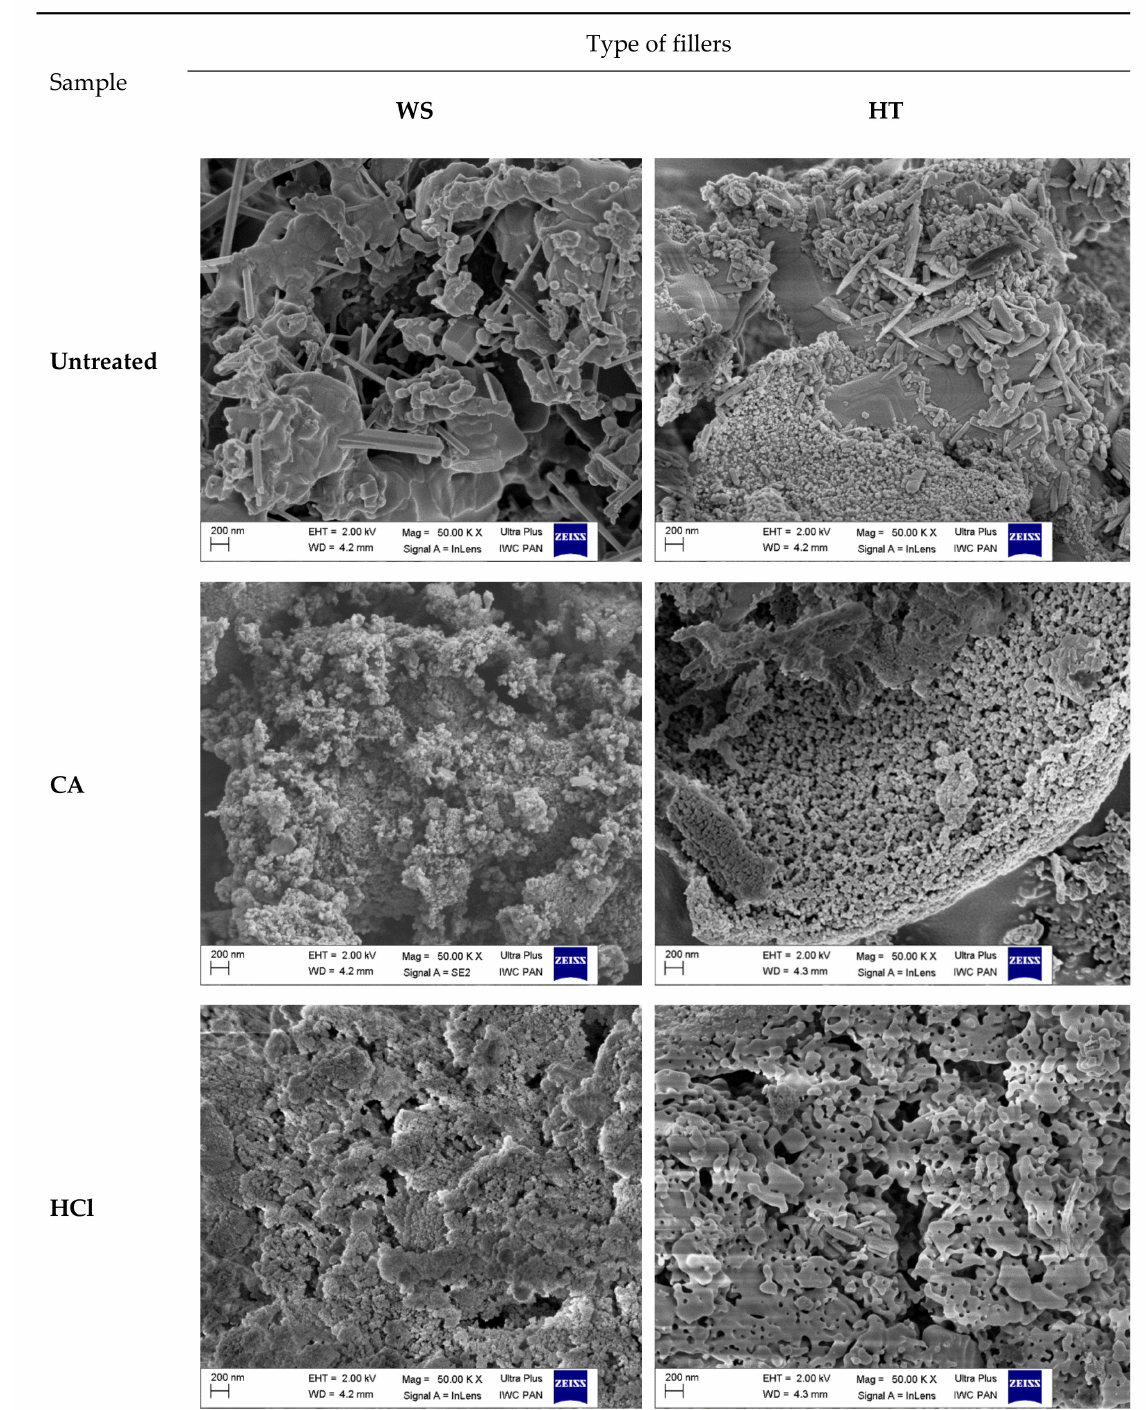
Figure 7. SEM images of